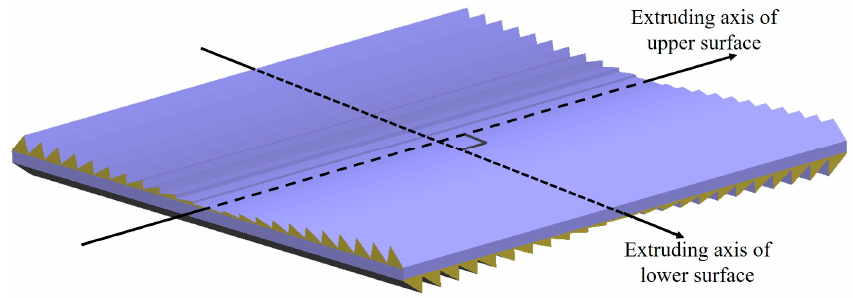
Figure 2. The structure of the novel Fresnel lens consisting of two surfaces placed perpendicular to each other.